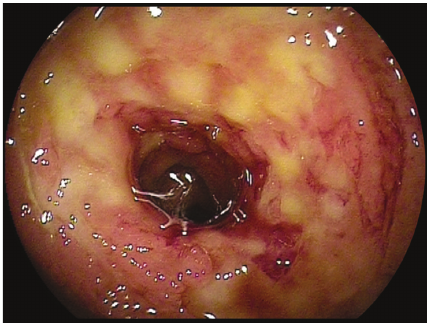
Figure 1: Double balloon enteroscopy. Severe inflammatory small intestinal involvement in front of tight stenosis of the